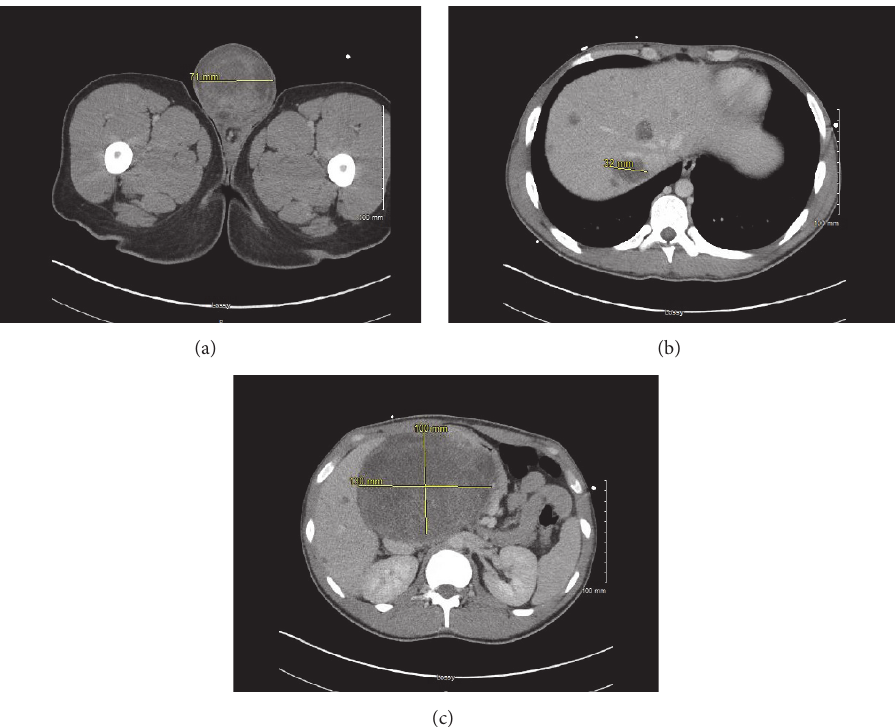
Figure 1: Pelvic computed tomography showing a 9 cm heterogenous mass in right testicle (a). Abdominal CT scan showed multiple hepatic masses (b) and one large heterogenous retroperitoneal mass (c) measuring up to 13cm in greatest dimension, consistent with metastatic